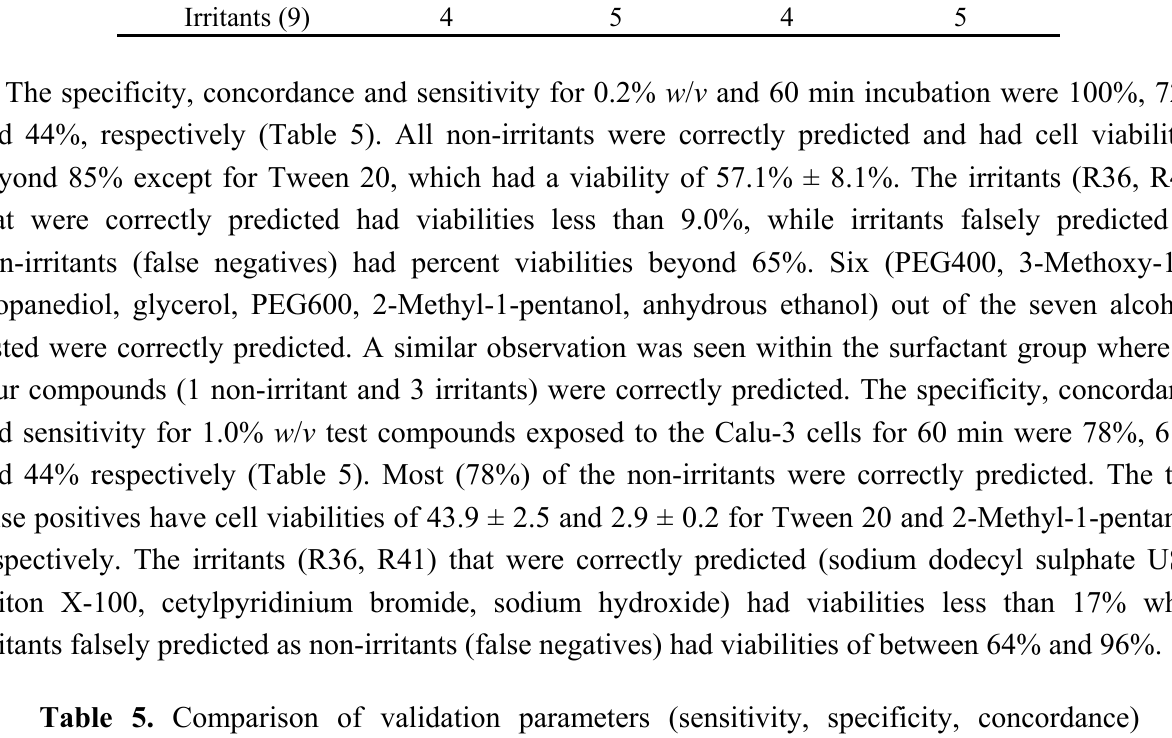
Table 5. Comparison of validation parameters (sensitivity, specificity, concordance) based on test compound concentration and 60 min exposure to Calu-3 cells. Comparison